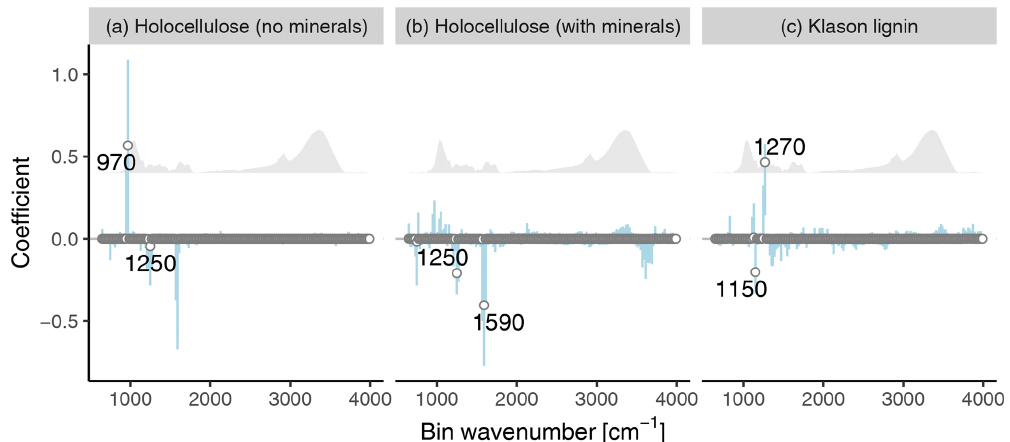
Figure 3. Coefficients of the best models using binned spectra for holocellulose ( a , b , model trained without and with samples containing minerals, respectively) and Klason lignin (c) , plotted against the average wavenumber of the bins. Points are median coefficient estimates, error bars are 90% posterior intervals. Points with an absolute median coefficient ≥ 0 . 2 are labeled with the respective average wavenumber value. The grey shaded region is a reference spectrum.